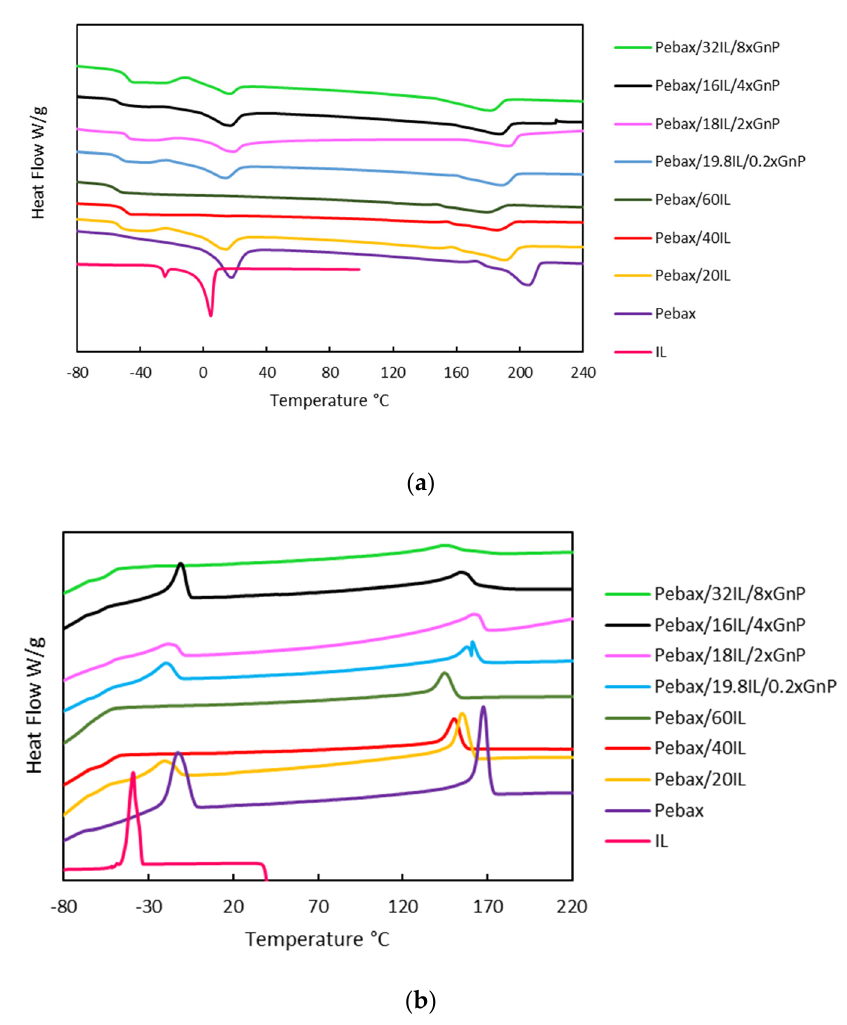
Figure 6. DSC thermograms of IL; Pebax; Pebax/20IL; Pebax/40IL; Pebax/60IL; Pebax/19.8IL/